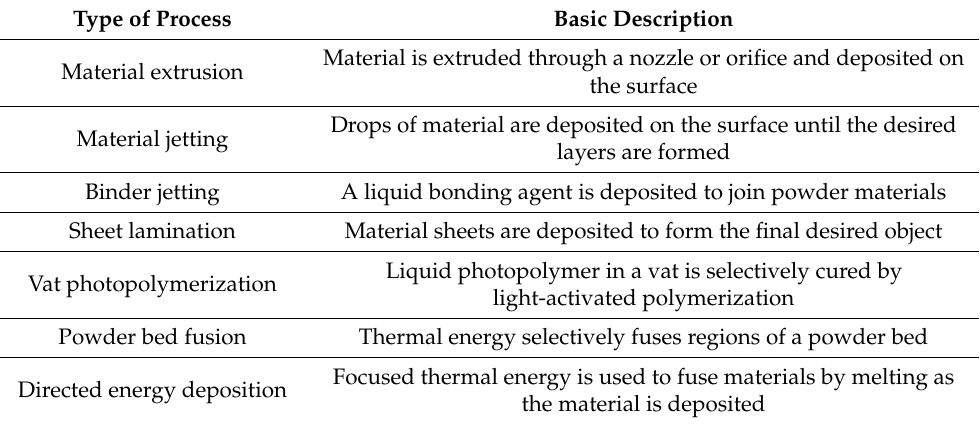
Table 3. ASTM F2792-12A standard terminology for additive manufacturing